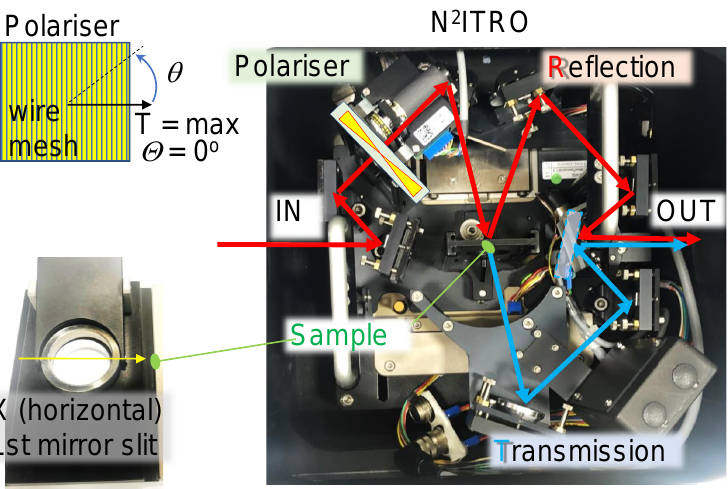
Figure 2. Beam tracing in the Near-Normal Incidence Transmission and Reflection Optics (N 2 ITRO, Bruker) unit with a step-motor controlled linear polariser. Measurements were carried out in vacuum ∼ 10 − 5 atm with the fabricated filters placed at the sample holder. Polariser position for maximum transmittance T was set as θ = 0 ◦